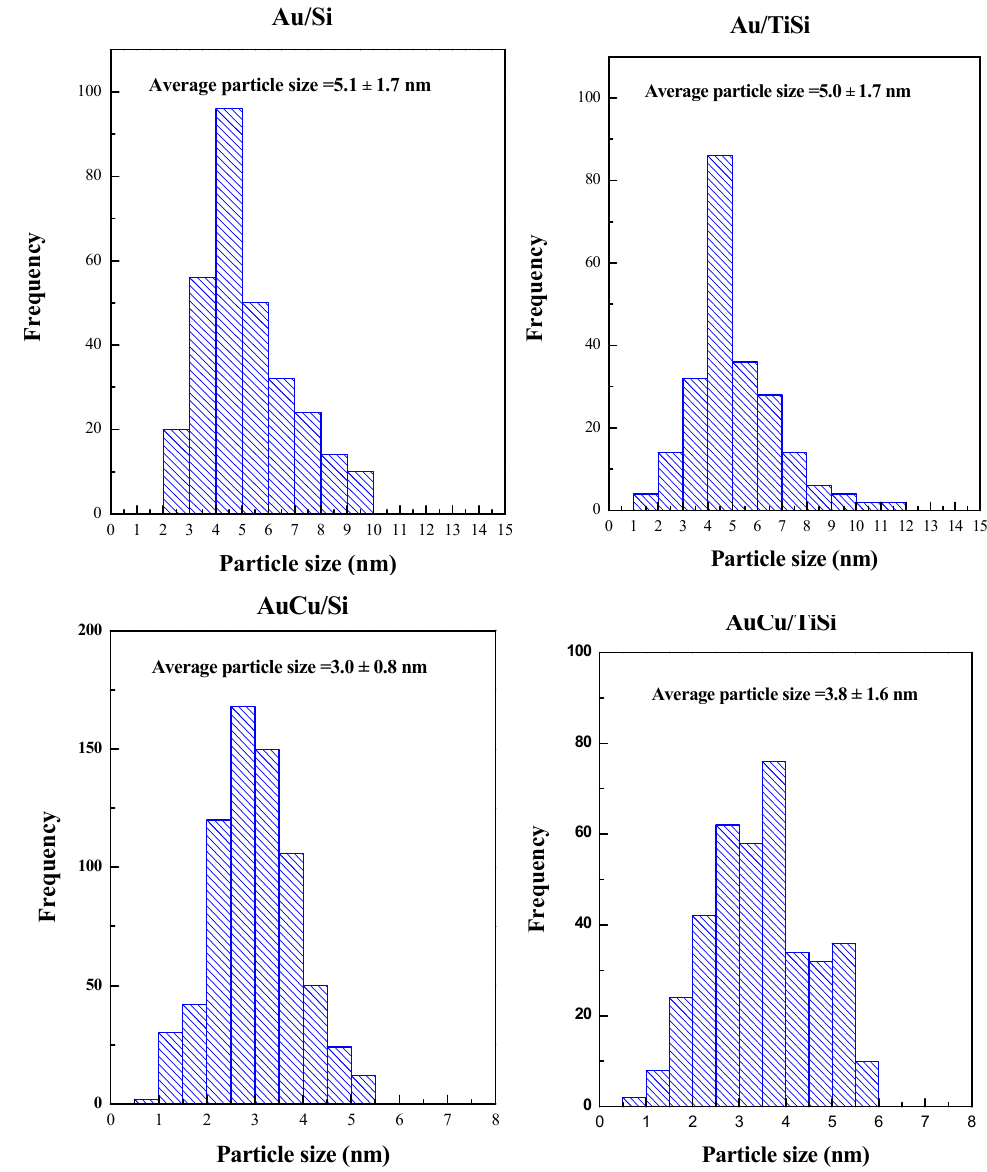
Figure 4. Particle size distribution obtained by TEM measurements.